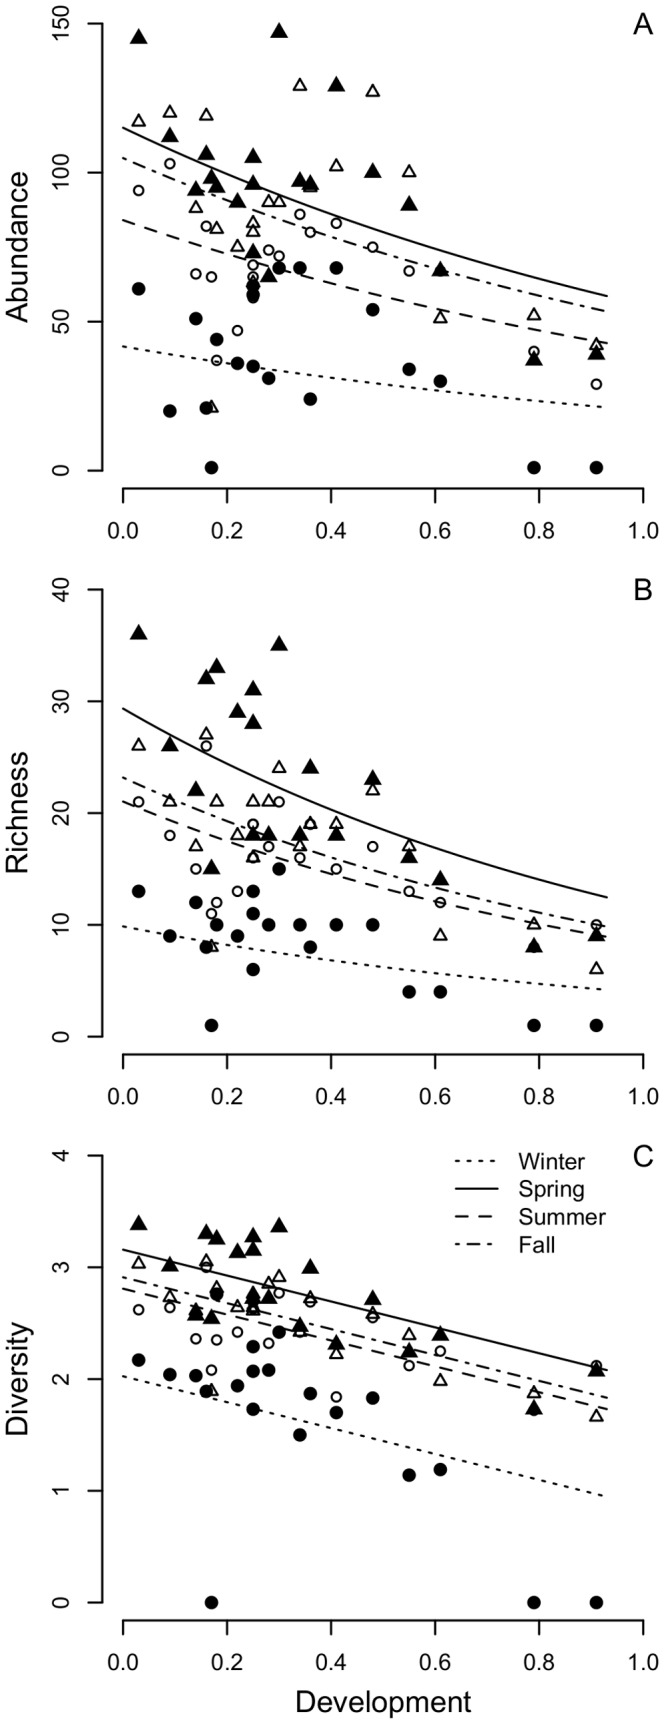
Effect of proportion of developed land on avian community structure.Relationships of avian (A) abundance, (B) richness, and (C) diversity are characterized for winter (closed circles), spring (closed triangles), summer (open circles), and fall (open triangles). Best-fit lines are indicated for each season and are based on parameter estimates from the most-supported models of each response variable (see Table 1).